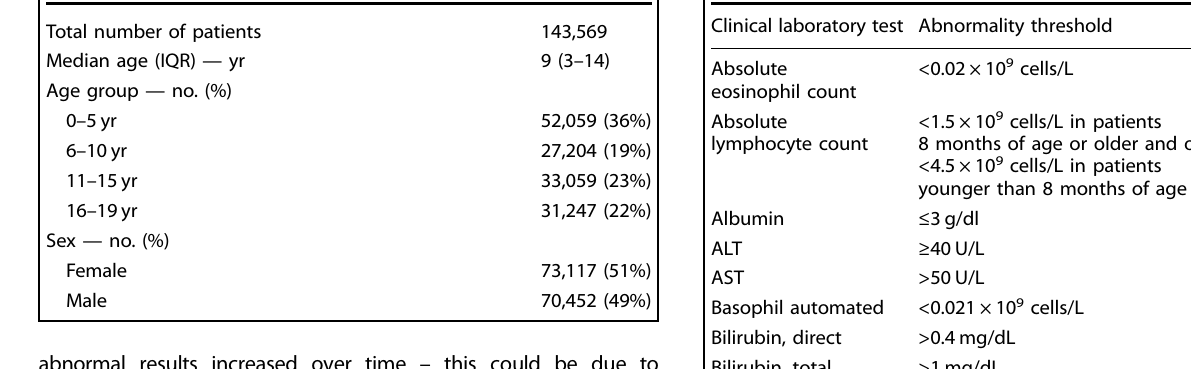
Table 2. Characteristics of the patient population. Table 3. Clinical laboratory tests with normal